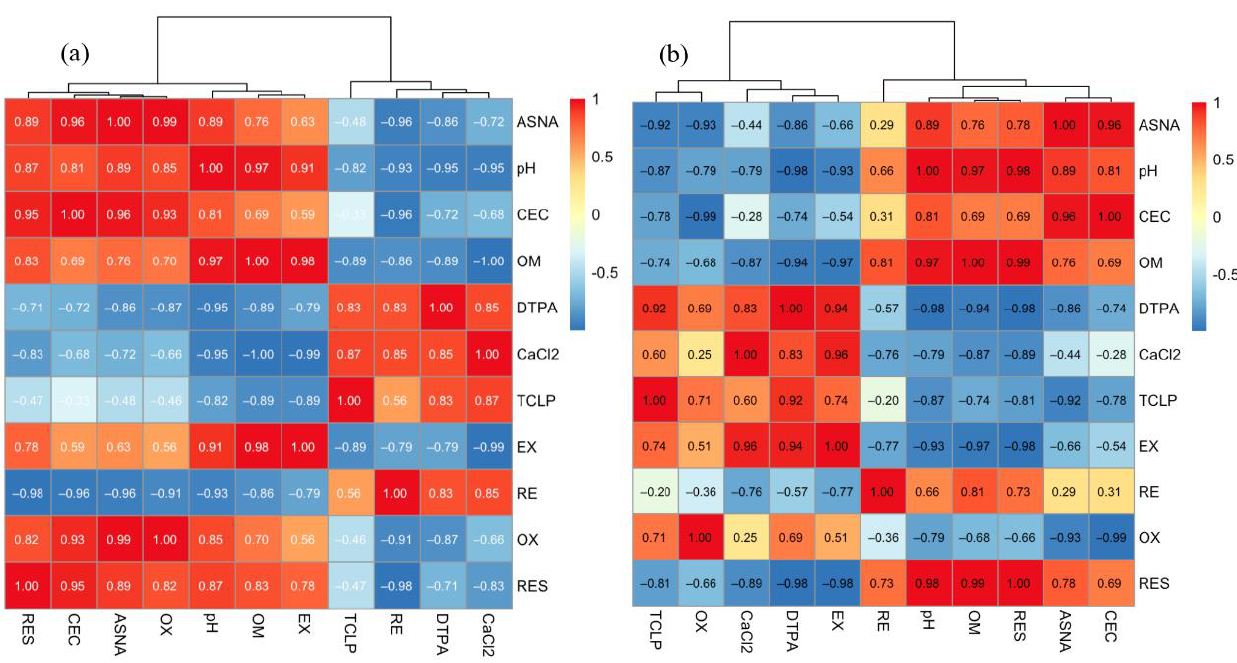
Figure 6. Cluster analysis of the correlation coefficients between soil physical and chemical properties and the chemical speciation and bioavailability of Pb ( a ) and Zn ( b ).